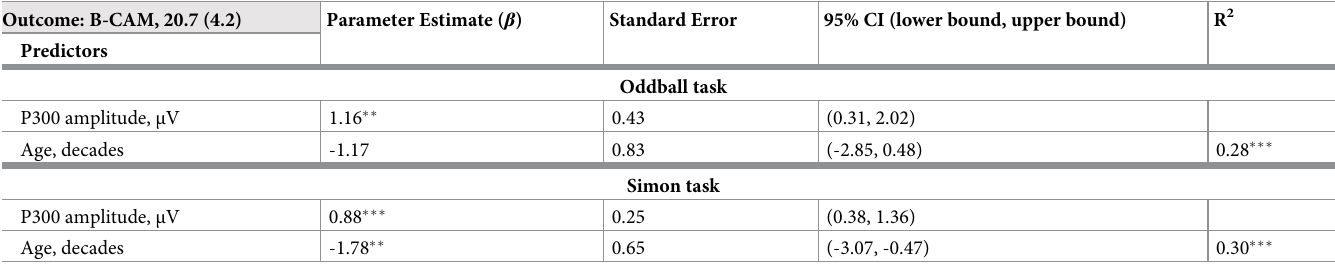
Table 2. Multiple linear regressions predicting cognitive ability (BCAM score). Outcome: B-CAM, 20.7